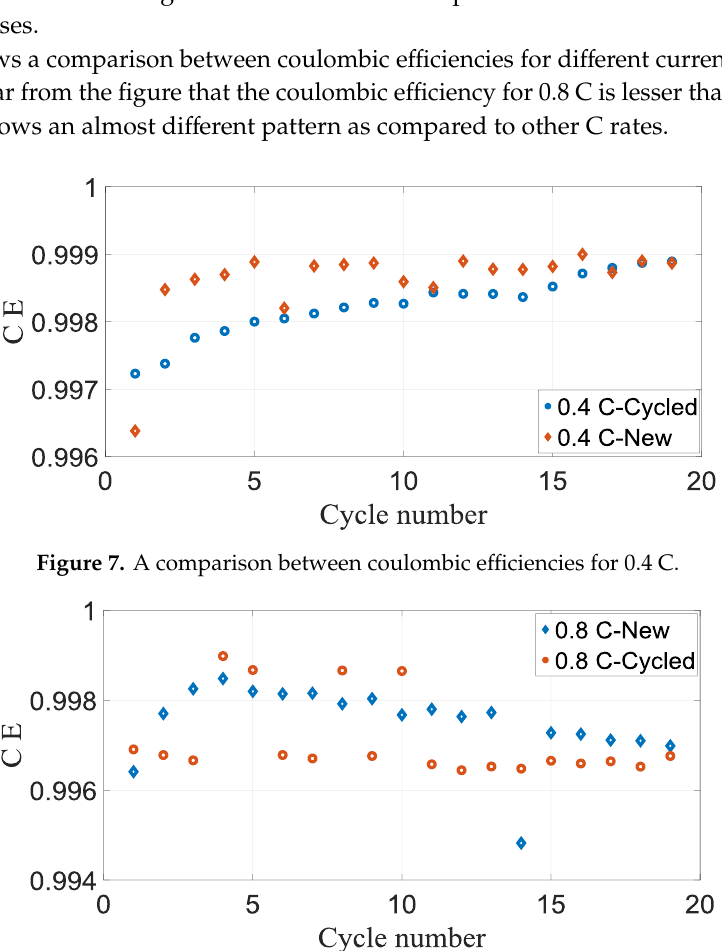
Figure 8. A comparison between coulombic efficiencies for 0.8 C.